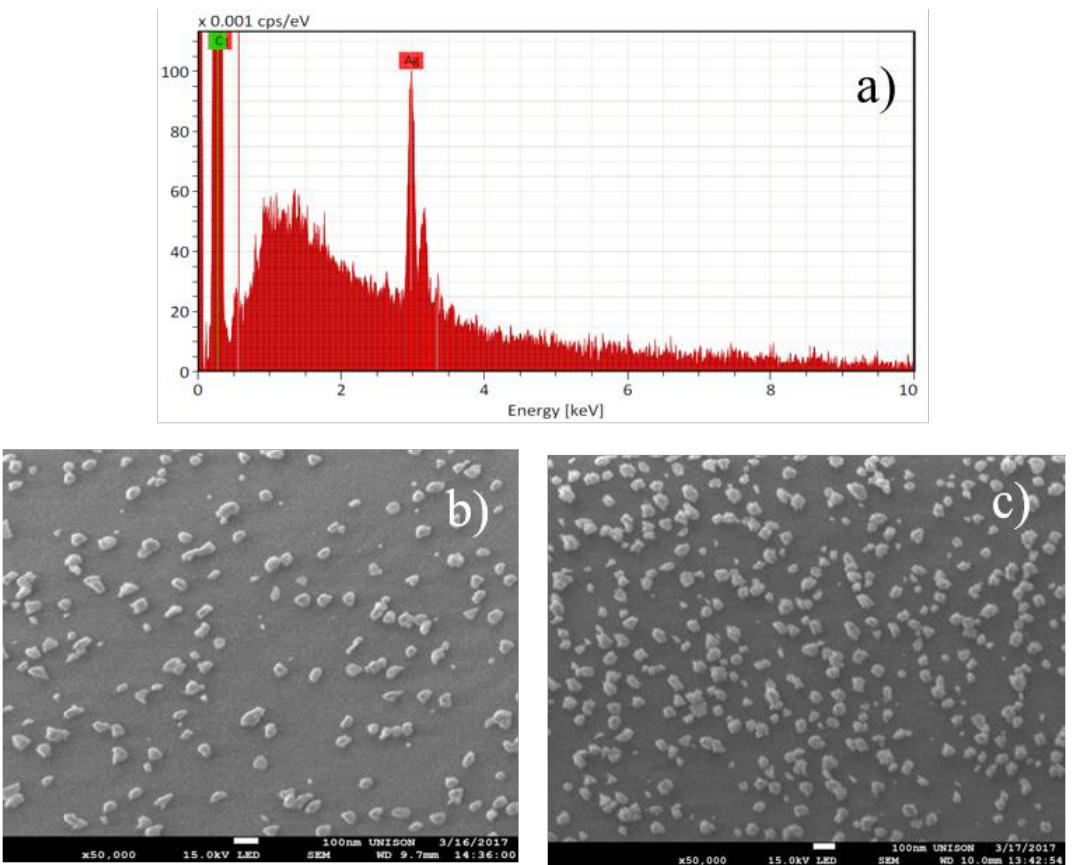
Figure 7. ( a ) EDS spectrum of the covered area on the polystyrene surface. It confirms the presence of AgNP. SEM micrographs of the AgNP deposited on polystyrene cell before ( b ) and after ( c ) measuring all the oil samples, no apparent variation in size or shape caused by interaction with degraded oil can be observed.